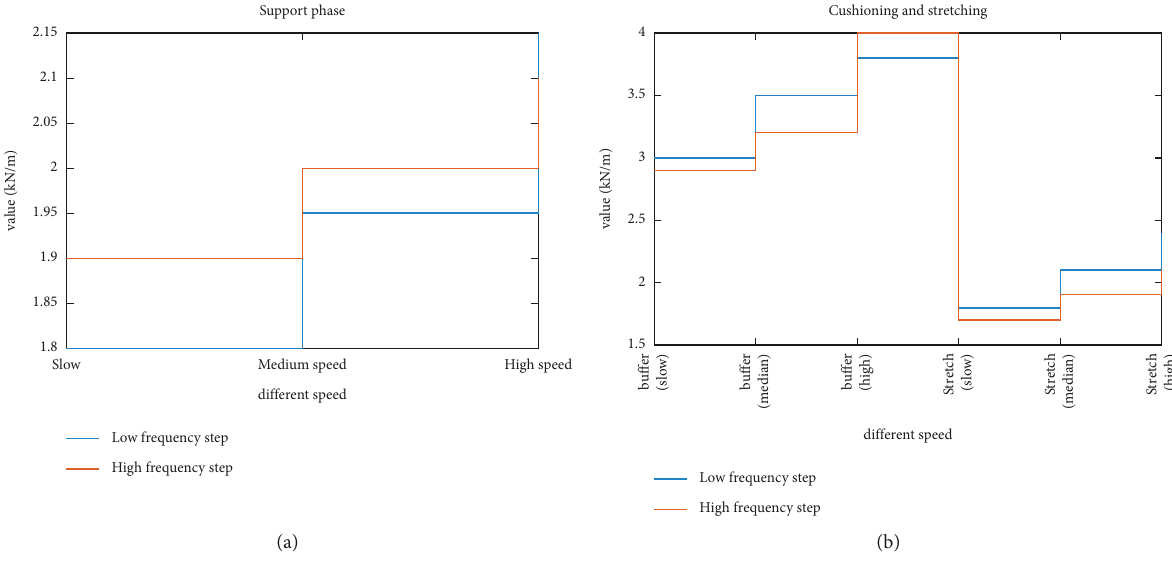
Figure 4: Analysis of lower limb stiffness at different frequencies. (a) Support phase; (b) cushioning and stretching.